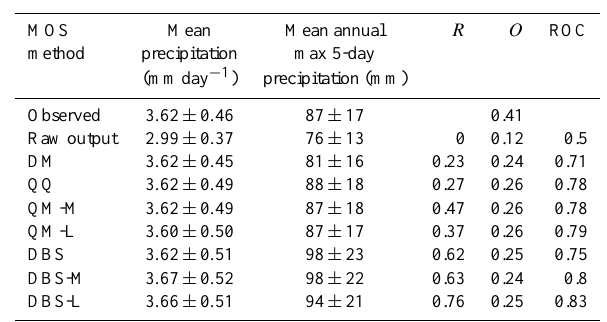
Table 2. Precipitation statistics for the MOS techniques calculated for the area upstream Montford.